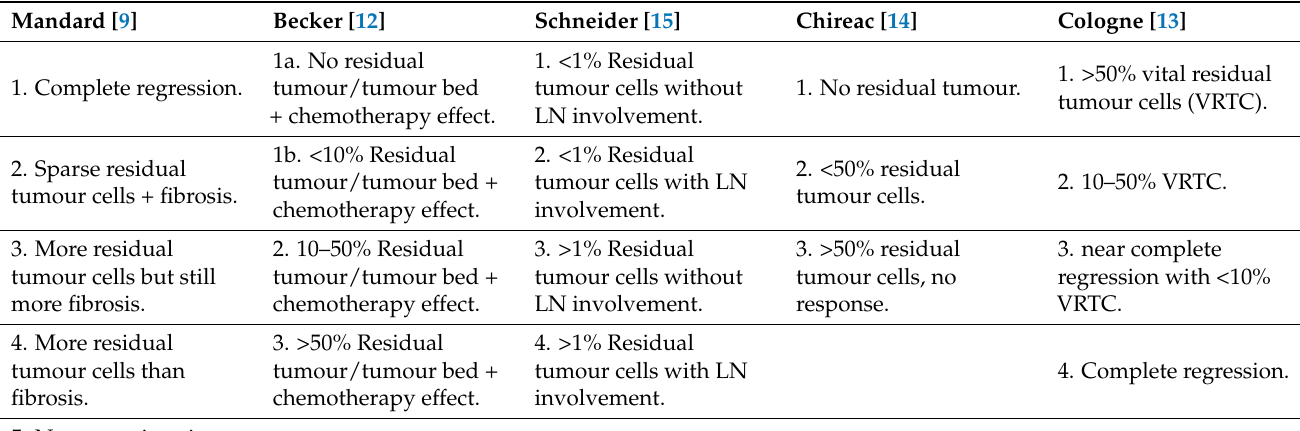
Table A11. NTumour regression grade classification